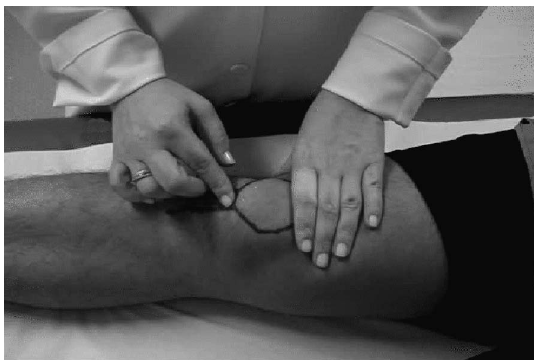
Figure 1 - Palpation of the inferior pole of the